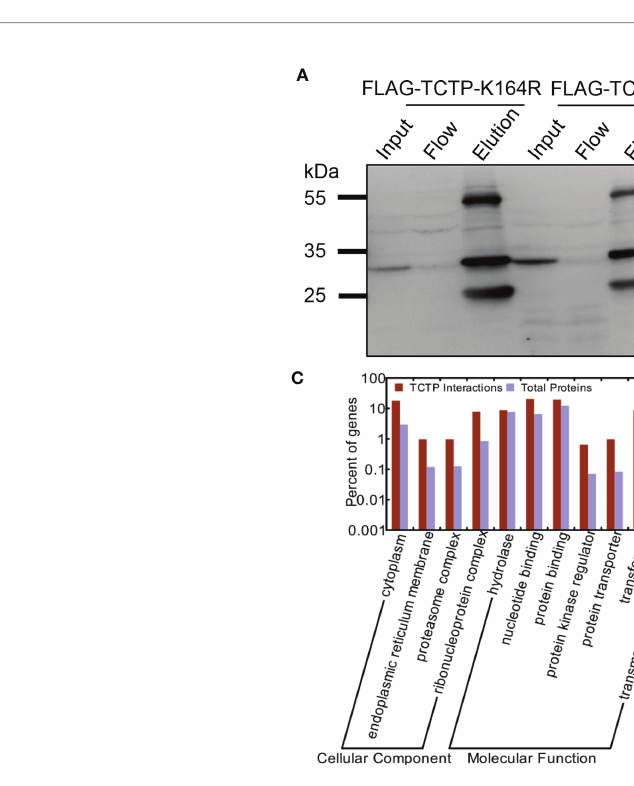
FIGURE 6 | Bombyx mori translationally controlled tumor protein ( BmTCTP ) interactome identi fi ed the interaction with an immune molecule Bombyx mori interleukin enhancer binding factor ( BmILF ). (A) The ef fi ciency of anti-FLAG antibody-mediated BmTCTP immunoprecipitation. Anti-FLAG antibody was used for both IP and immunoblotting (IB). The input, fl ow, and elution proteins were resolved on 10% SDS-PAGE gels and probed with anti-FLAG antibody. IgG-L and IgG-H were the light and heavy chains of anti-FLAG antibody. (B) Venn diagram assay of the FLAG-TCTP-WT and FLAG-TCTP-K164R interacting proteins identi fi ed by liquid chromatography-tandem mass spectrometry (LC-MS/MS). The LC-MS/MS data for each expression plasmid were shown in Table S2 . (C) Functional categories of the interacting proteins were analyzed by WEGO. Proteins were classi fi ed into cellular component, molecular function, and biological process according to their Gene Ontology (GO) signatures, and the total silkworm genes were shown as a